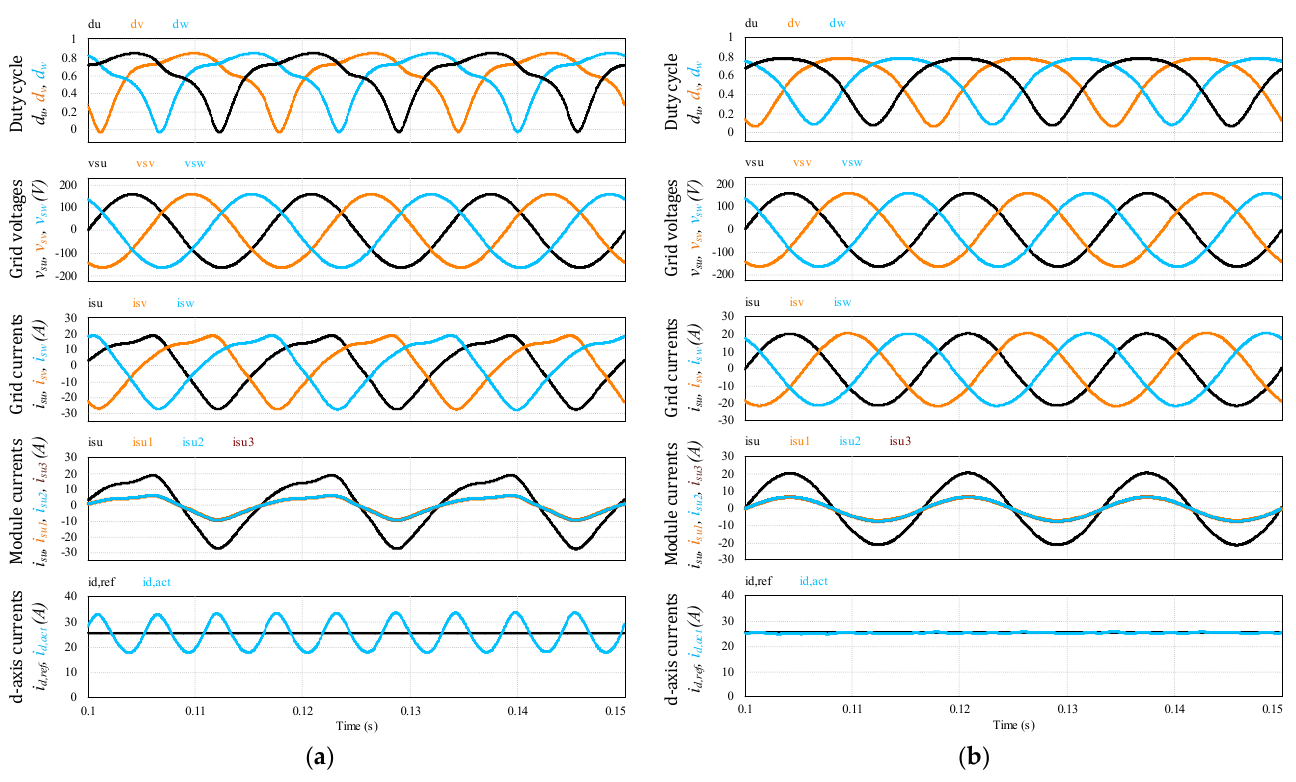
Figure 12. Simulation results of the proposed MFBDI at 5 kW; ( a ) with SOHC, ( b ) without SOHC. Table 5. Simulation parameters of the MFBDI. In addition, a 15% mismatch between the parameters of the flyback parallel modules of (u-phase) to investigate the proposed converter operation during parameters divergence.